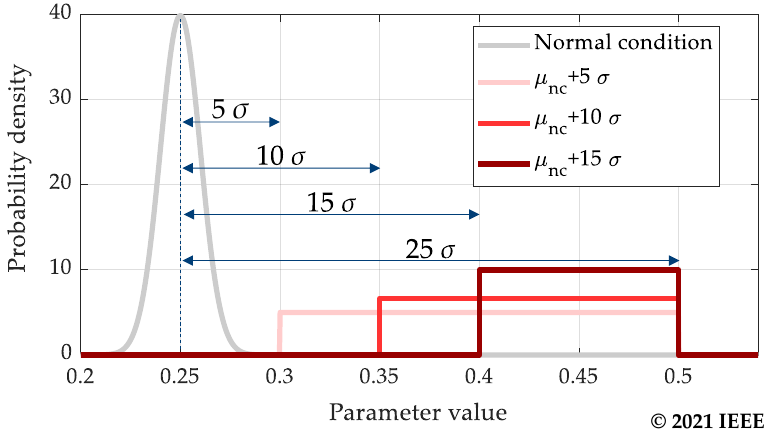
Figure 2. Introduction of an abnormal-condition probability distribution in relation to the normal condition’s probability distribution [25].